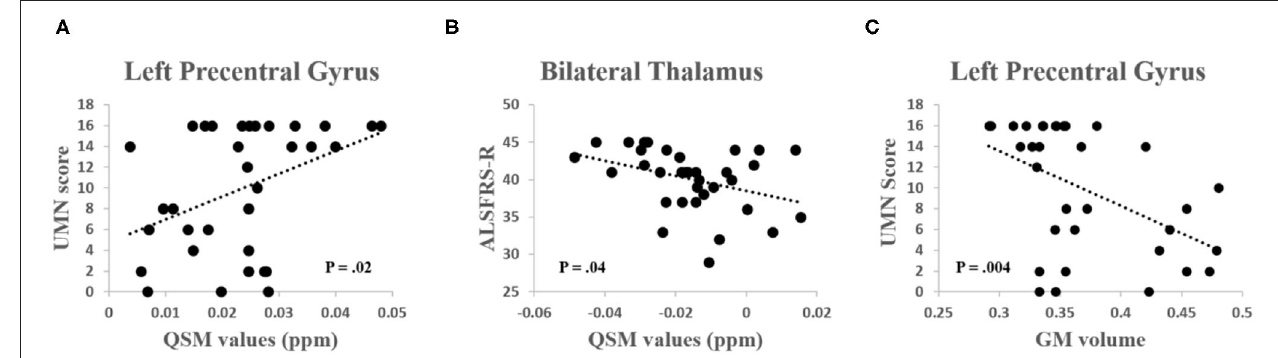
FIGURE 4 | (A) A significant positive correlation was found between the QSM values in the left precentral gyrus and the upper motor neuron (UMN) score ( R = 0.40, P = 0.02). (B) A significant negative correlation was found between the QSM values in the thalamus and the Revised ALS Functional Rating Scale (ALSFRS-R) score ( R = − 0.36, P = 0.04). (C) A significant negative correlation was found between the GM volume in the left precentral gyrus and the UMN score ( R = − 0.48, P =